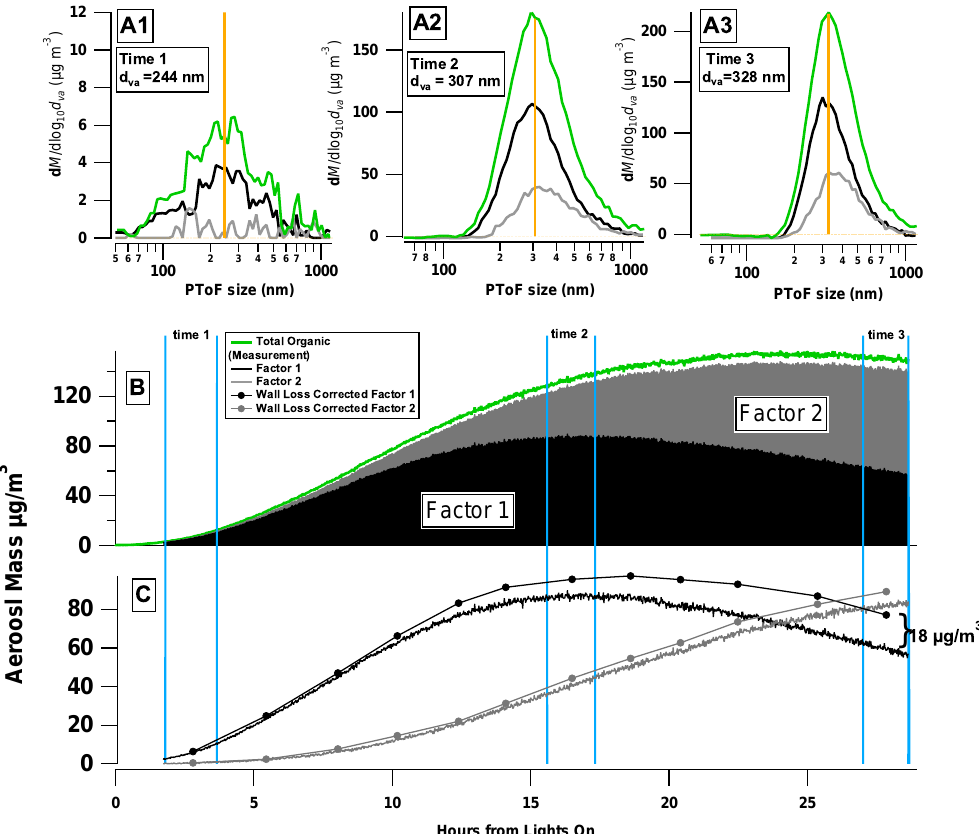
Fig. 14. Mass distributions ( A1 , A2 and A3 ) and time series (B) of total organic mass (green) broken down into 2 factors (black and grey). The average diameter for each mass distribution is highlighted by the yellow bar, and the time associated with each distribution is outlined with the two blue bars on the time series graphs. The wall-loss corrected versions of the individual factor time series are also shown (C)